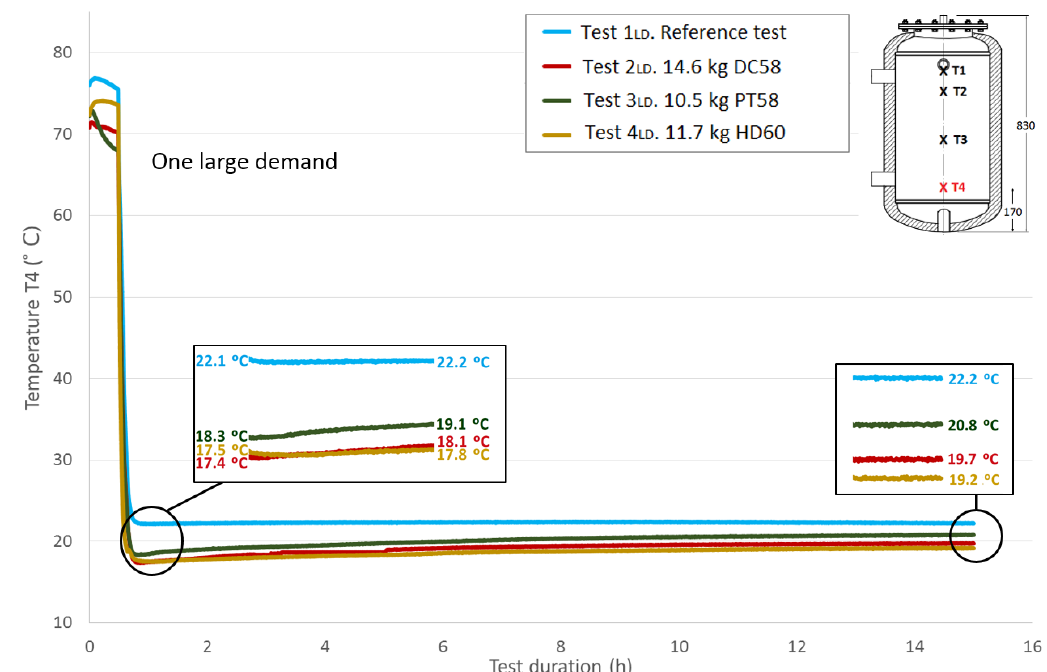
Figure 11. Bottom height water temperature ( T 4) inside the tank during the one large demand experiment. (dimensions are in mm).